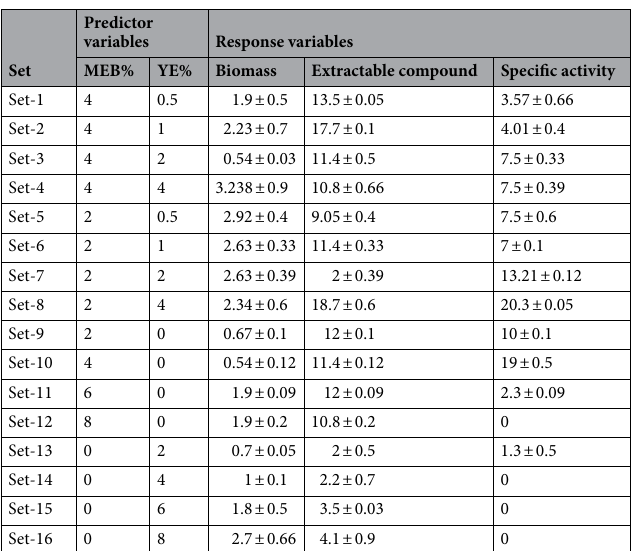
Table 2. Table presenting experimental details. Here, the values of the response variables are the average of duplicate trials ± SE.